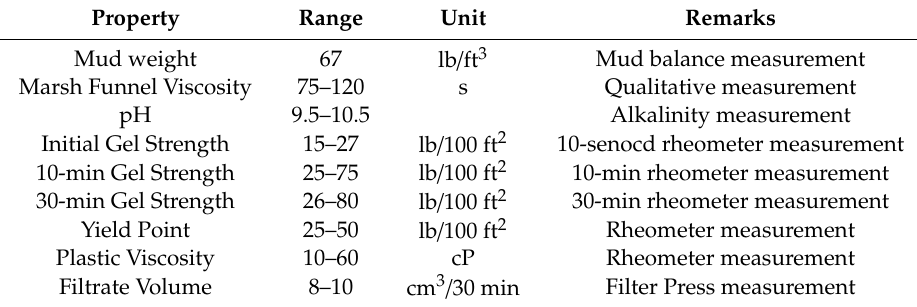
Table 5. Reference rheological properties of field high-bentonite mud formulation.